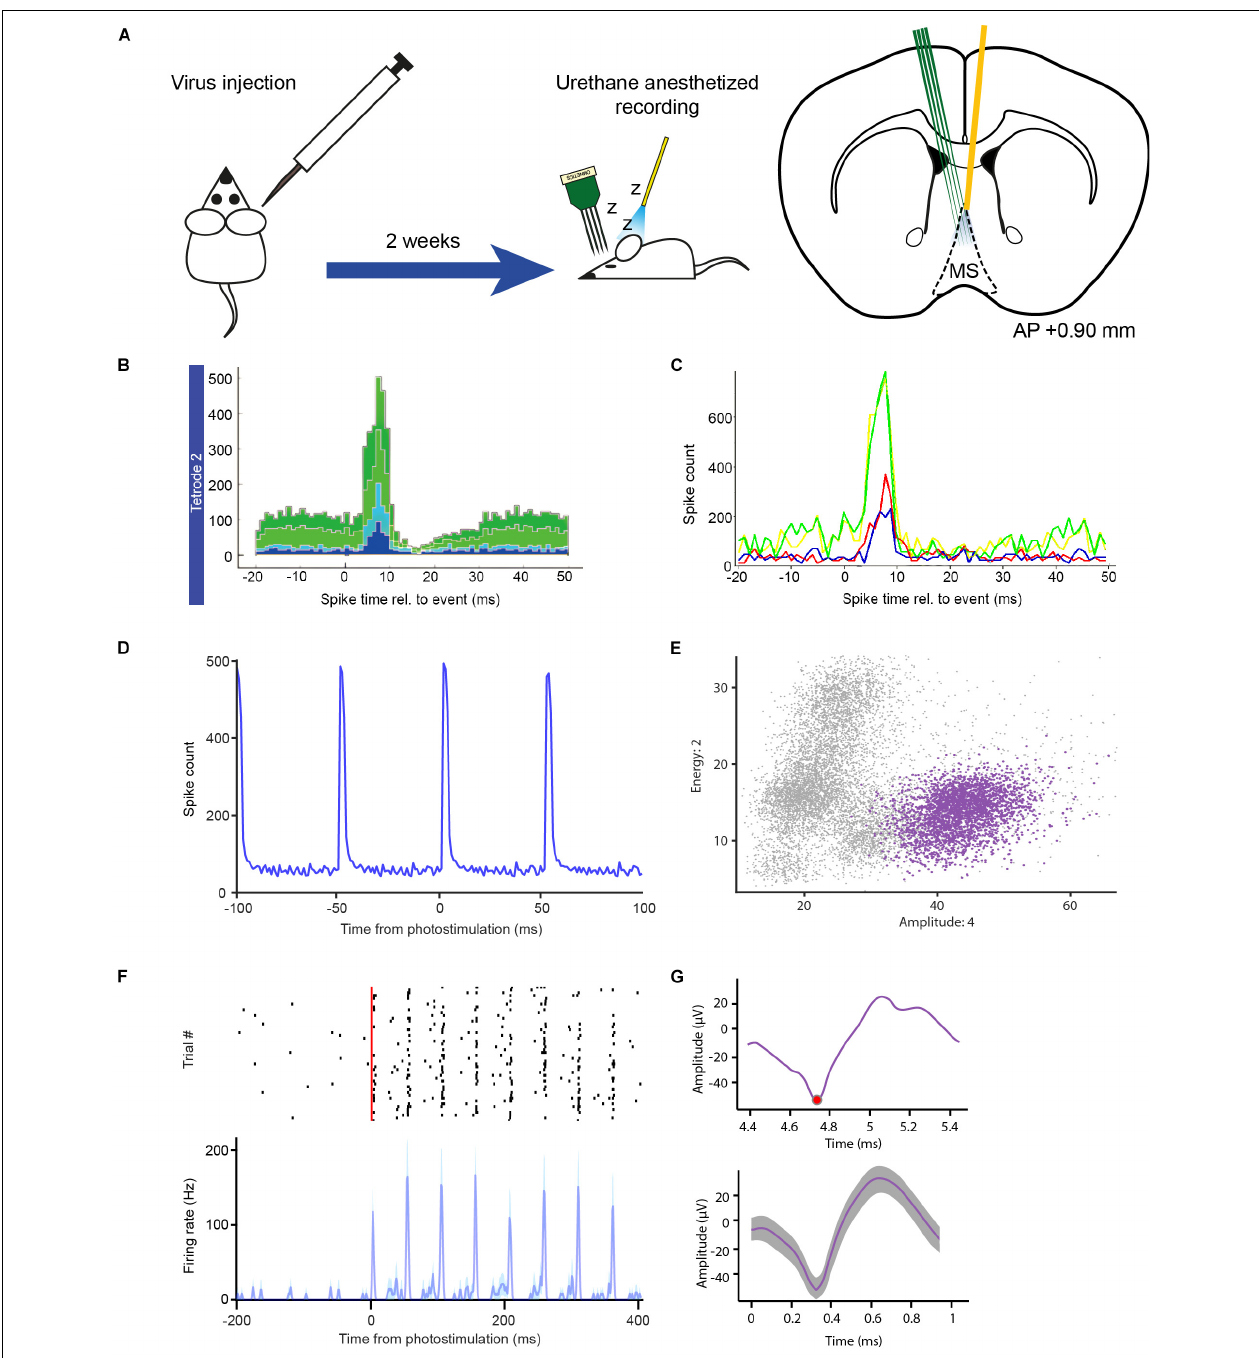
FIGURE 6 | In vivo optogenetic tagging experiment for testing OPETH. (A) Transgenic animals were virus injected and, after a 2 weeks recovery period, acute recordings were performed under urethane anesthesia, in which a 32-channels silicon probe and an optic fiber were inserted in the MS in order to record light-activated units. (B) OPETH Histogram Window (“aggregate view”) shows neural responses to laser pulses in a Vglut2-Cre mouse expressing channelrhodopsin2 (1 ms bin size). (C) OPETH “ Channel view” of the same recording was used to determine the most responsive channel of the tetrode of interest. In this view, histograms are calculated separately for single channels (arbitrary color code). (D) The offline peri-event time histogram calculated from all spikes of the same tetrode (unsorted data of all neurons) confirmed the presence of strong light-evoked activity. (E) Spikes from the same tetrode were sorted into putative single neurons using MClust 3.5. The plot shows an optotagged neuron in feature space (purple). Note the relatively small deviations around the cluster centroid, characteristic to real spikes in contrast with light-evoked artifacts. (F) Spike raster (black, spike times) and peri-event time histogram of the sorted MS single neuron example aligned to the onset of the laser pulse train (red), from the channel selected via OPETH (resolution, 1 ms). (G) Top, raw light-evoked spike in the OPETH Spike window . Bottom, average spike shape of the same neuron analyzed offline.